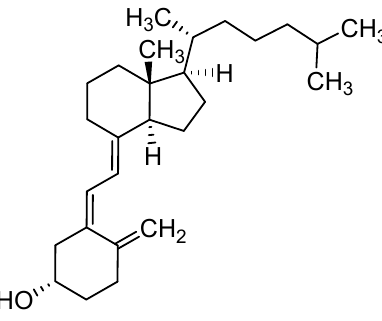
Figure 8. Structure of